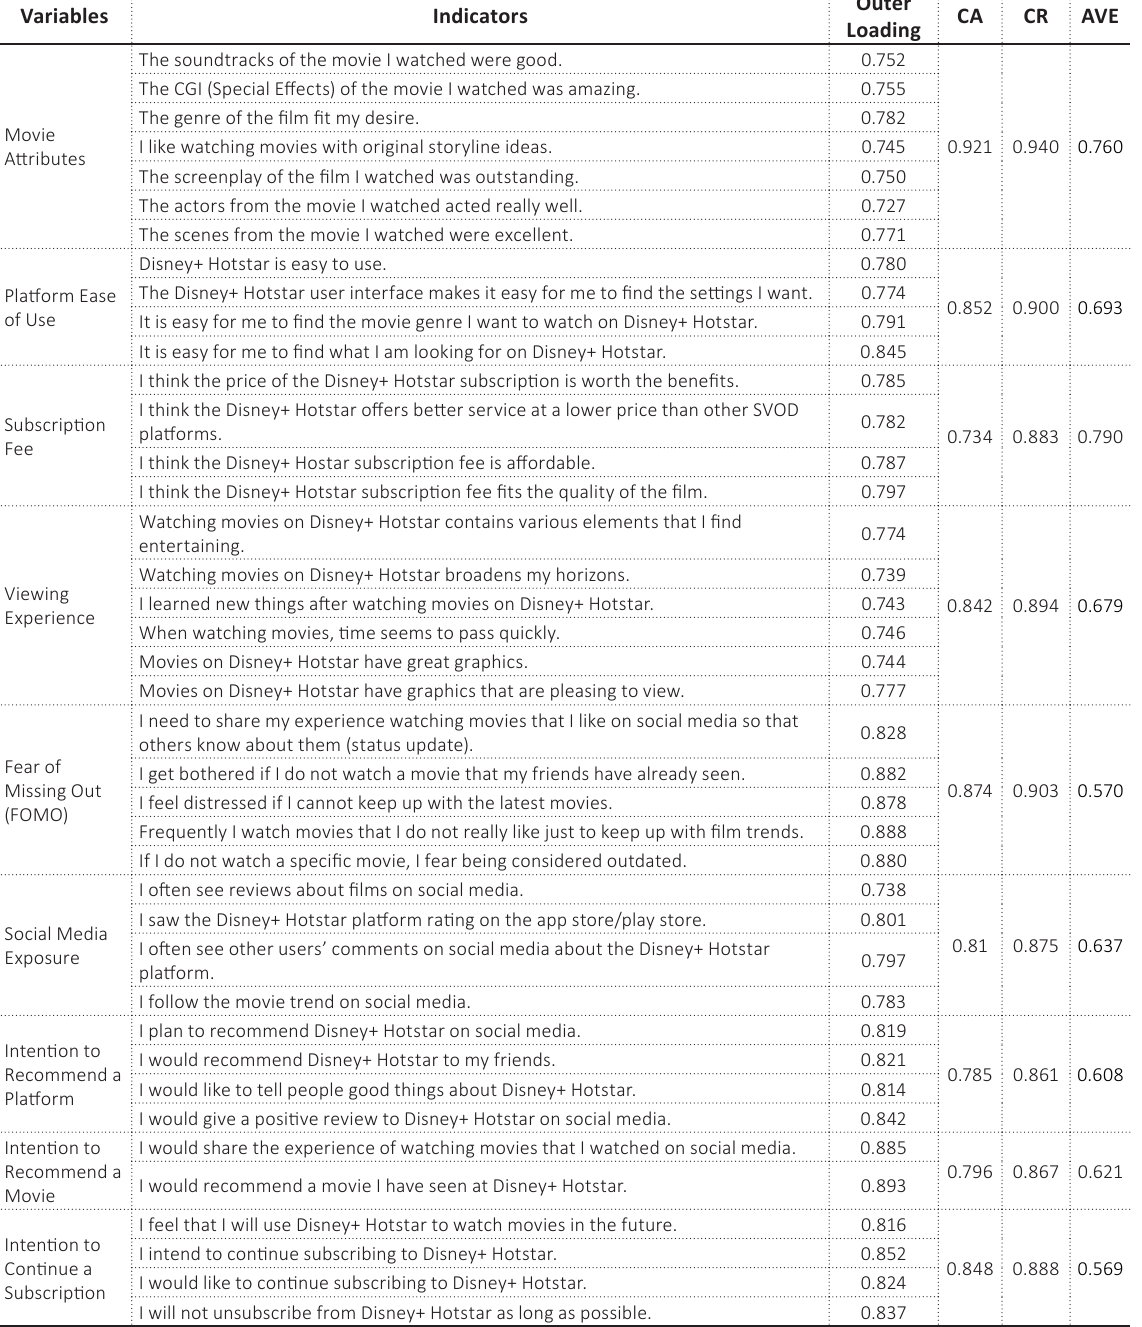
Table 2. Discriminant and construct